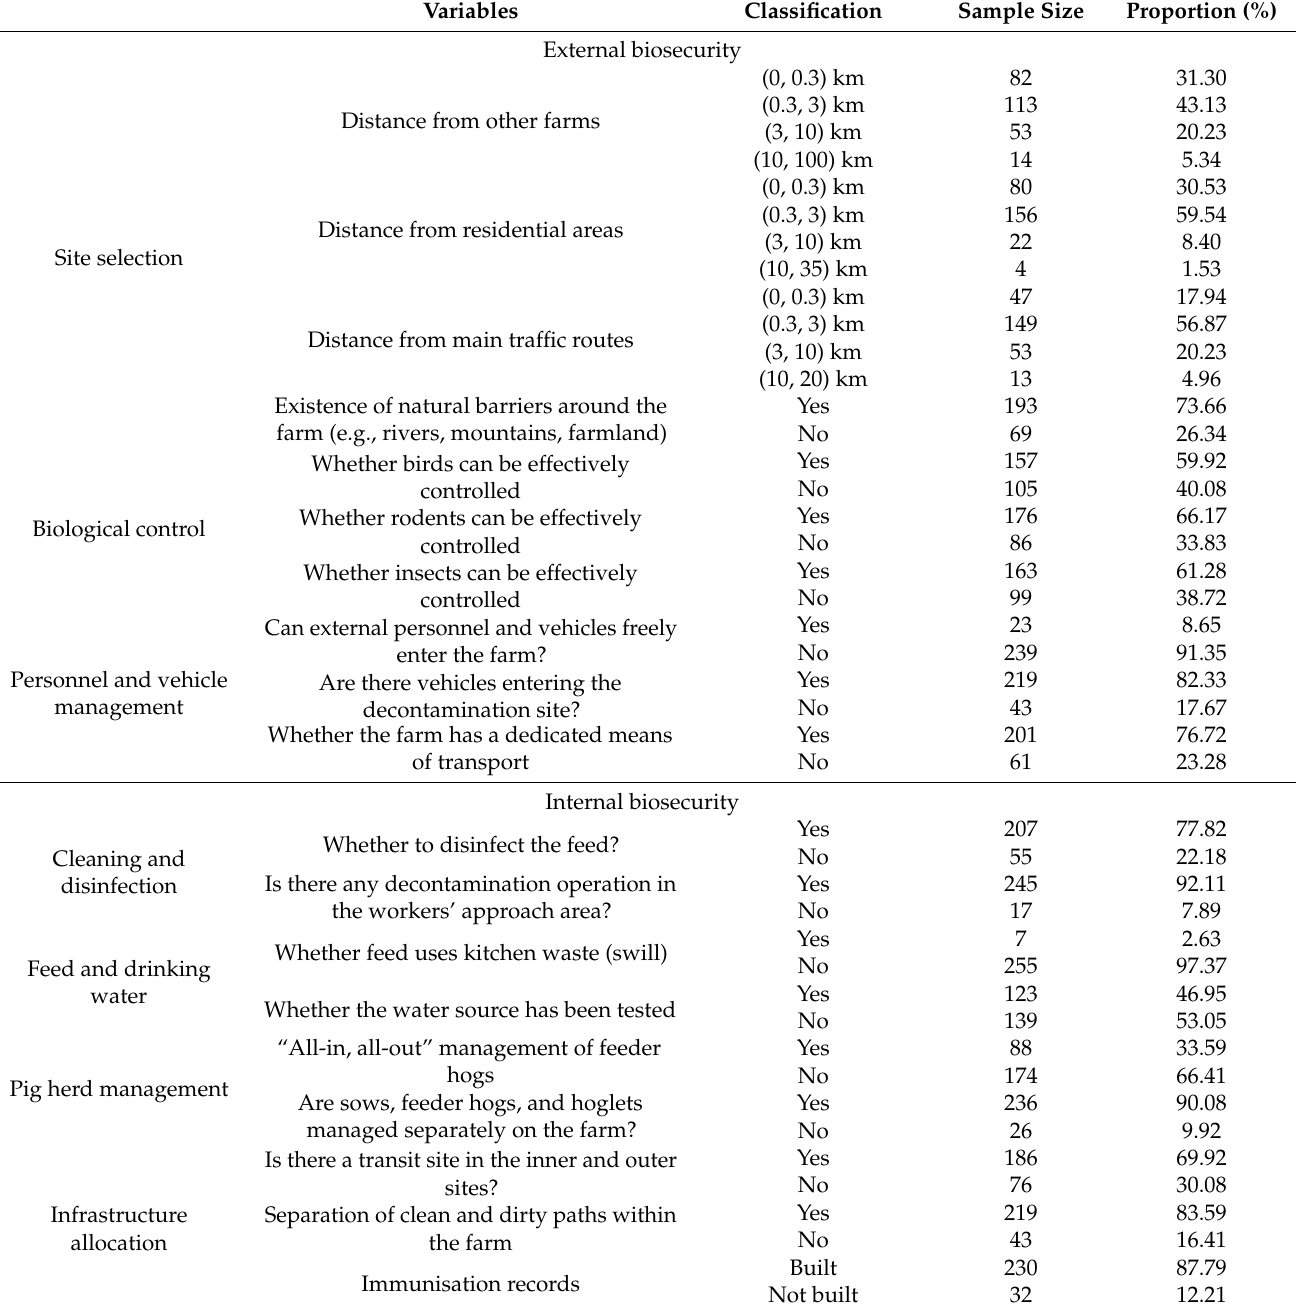
Table 4. Prevention and control of internal and external biosecurity in pig